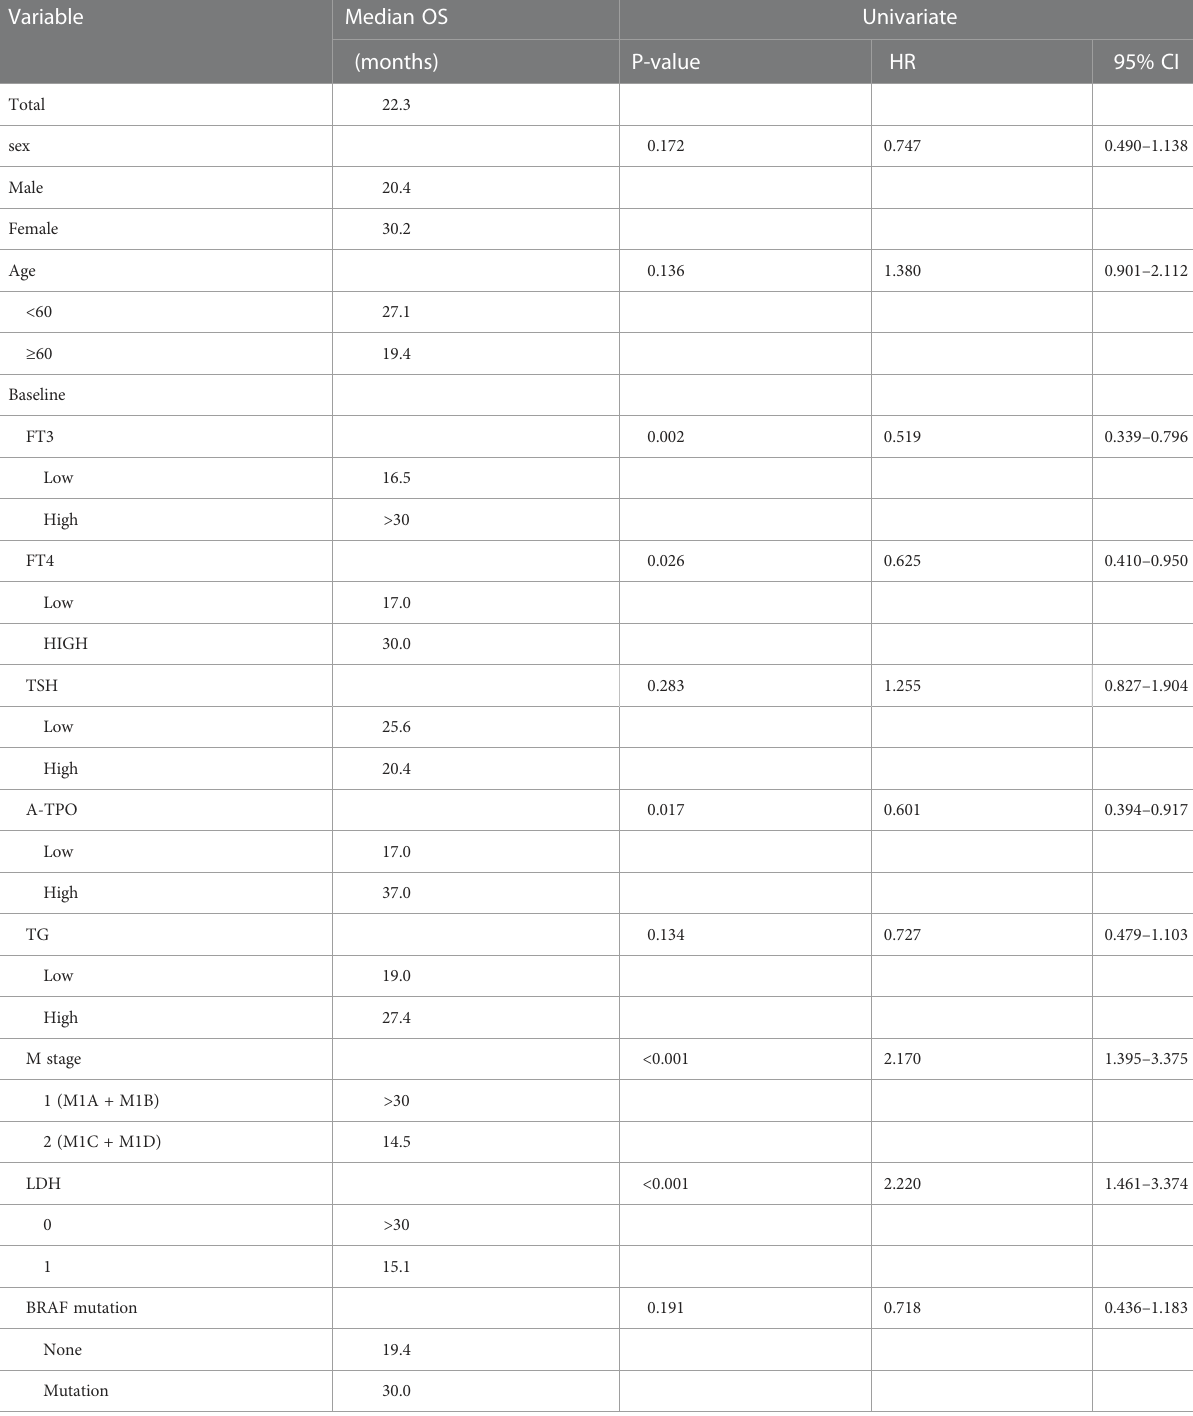
TABLE 3 Univariate Cox regression analysis of in fl uencing factors of overall survival